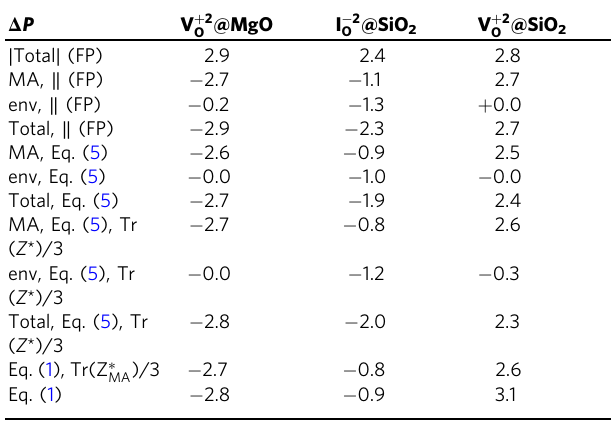
“ ∣ Total ∣ (FP) ” is the modulus of the FP Total polarization change. The labels “ MA ” and “ env ” refer to the contribution of the moving atom and the environment, respectively. The symbol “ ∥ ” refers to the polarization component parallel to the MA displacement vector ( d matrix. Values for the single label “ Eq. (1) ” are calculated using the oxidation level of the